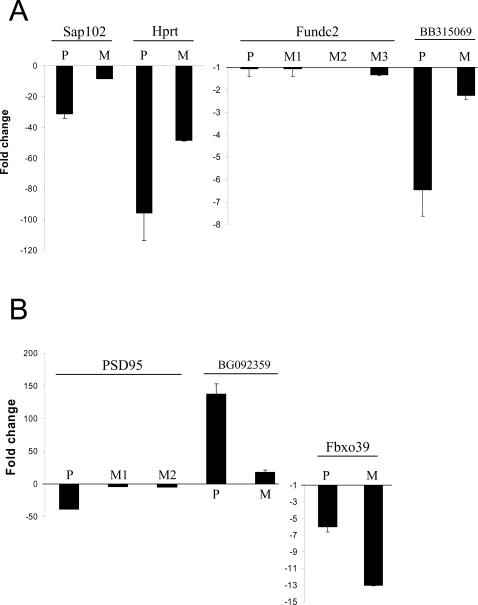
Validation of microarray analyses by qRT-PCR assays in PSD-95 and SAP102 mutants.Hippocampus mRNA was extracted and level of mRNA detected using microarrays or qRT-PCR. A, SAP102 mutant mice; results for SAP102, Hprt, Fundc2, BB315069 (3′ to Fundc2) are shown. B. PSD-95 mutant mice; results for PSD-95, Fbxo39 and BG092359 (3′ to Fbxo39). y-axis: fold change of mutant mRNA levels compared to control; mean±s.e.m. P, qRT-PCR data; M, microarray data. M1, M2… refers to different probe sets for the same gene. Note different scale of y-axes.